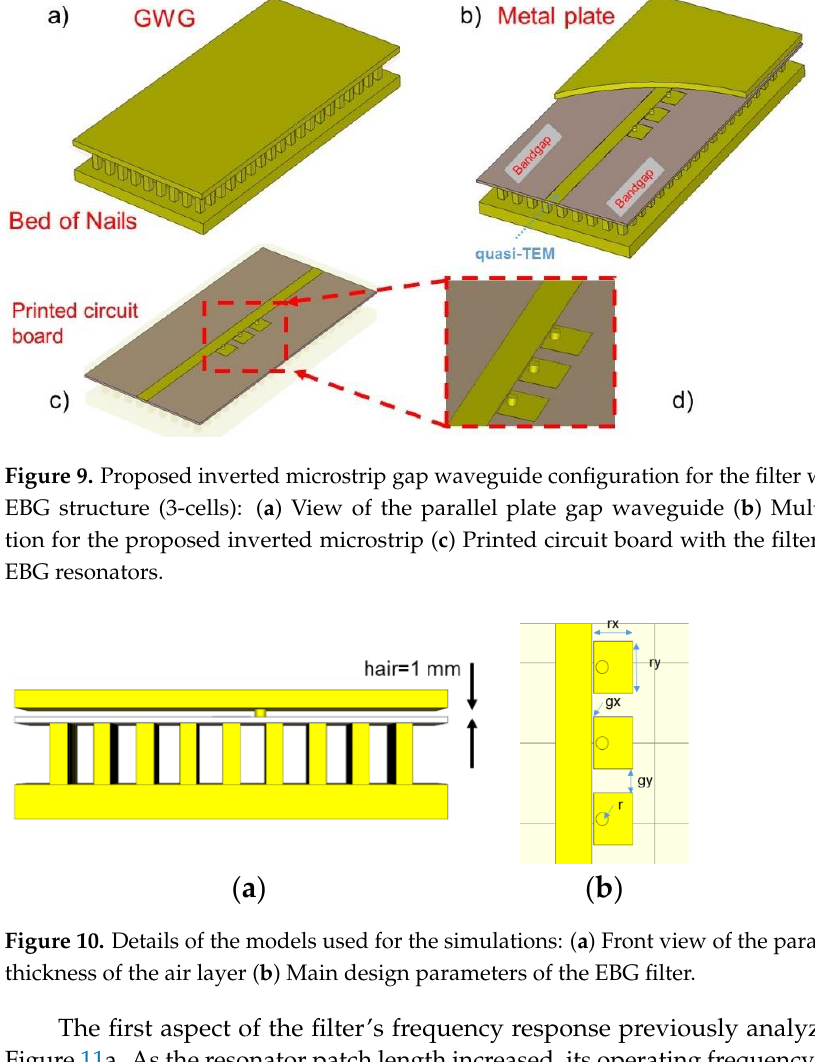
Figure 9. Proposed inverted microstrip gap waveguide configuration for the filter with the trun- cated EBG structure (3-cells): a) View of the parallel plate gap waveguide b) Multilayer configura- tion for the proposed inverted microstrip c) Printed circuit board with the filter d) Detail of the EBG resonators